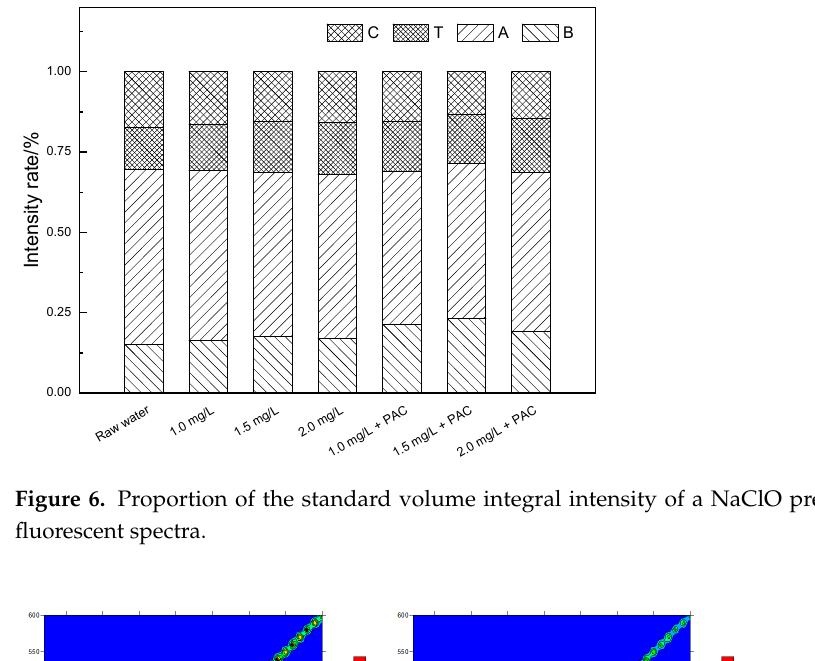
Figure 5. Fluorescence spectra of raw water and NaClO pre-oxidized effluent: ( a ) raw water; ( b ) 1.0 mg/L; ( c ) 1.0 mg/L + PAC; ( d ) 1.5 mg/L; ( e ) 1.5 mg/L + PAC; ( f ) 2.0 mg/L; ( g ) 2.0 mg/L + PAC.